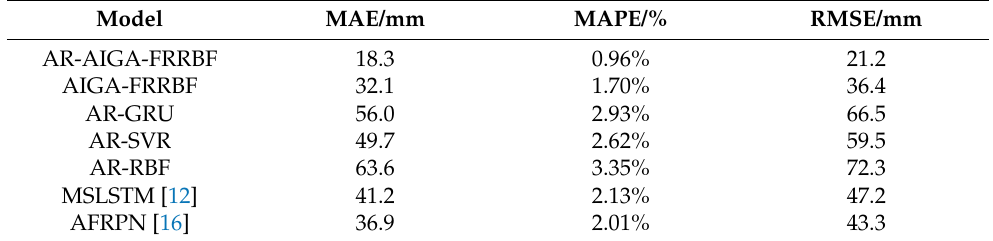
Table 12. Comparison of prediction performance of left drum height of shearer with different models.